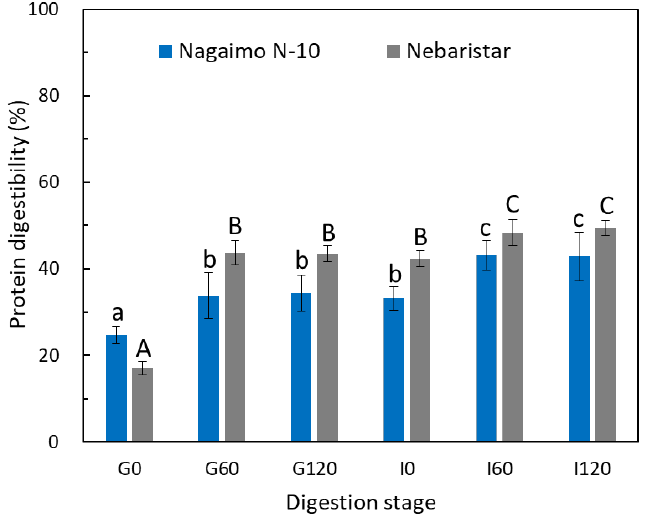
Figure 2. Changes in protein digestibility (%) of the raw yam tubers during simulated in vitro digestion. Different lowercase letters (a–c) indicate significant differences ( p < 0.05) for the Nagaimo N-10 sample collected at different digestion stages. Different uppercase letters (A–C) indicate significant differences ( p < 0.05) for the Nebaristar sample collected at different digestion stages.